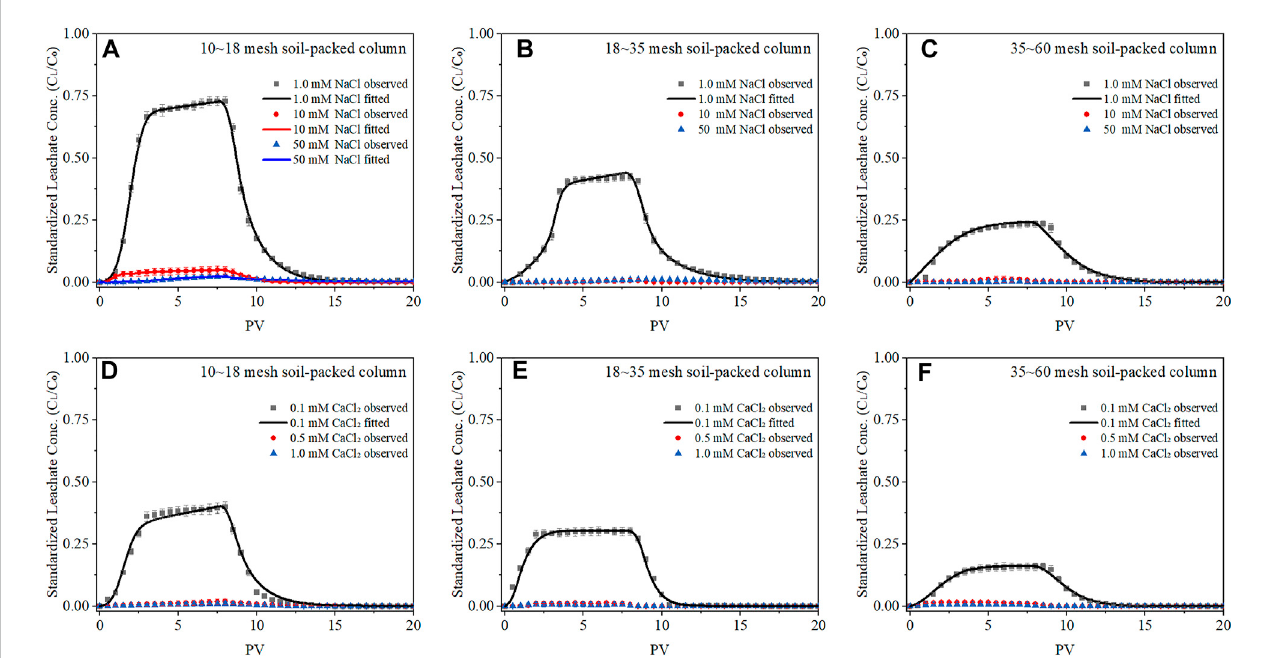
FIGURE 2 Observed (solid symbols) and fi tted (solid lines) breakthrough curves of biochar nanoparticles (BC-NP) as a function of pore volume (PV) at varying concentrations of NaCl [1.0, 10, and 50 mM; (A – C) ], CaCl 2 [0.10, 0.50, and 1.0 mM; (D – F) ] in packed columns with different soil grain sizes (10~18, 18~35, 35~60 mesh). Error bars represent the standard deviation of means ( n =